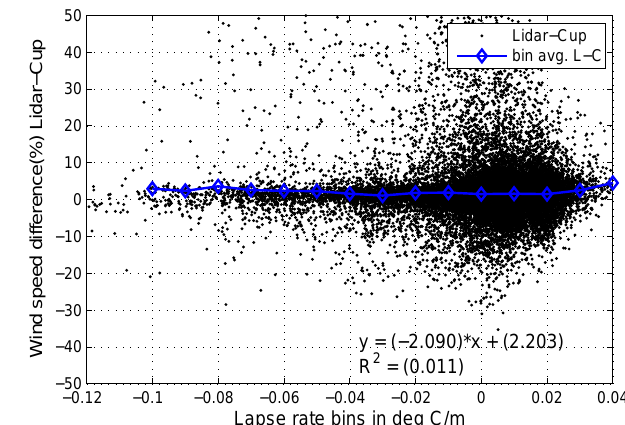
Figure 4. Sensitivity analysis(Slope multiplied with the range) of deviation of wind speed between Lidar and cup anemometer against the Lapse rate.